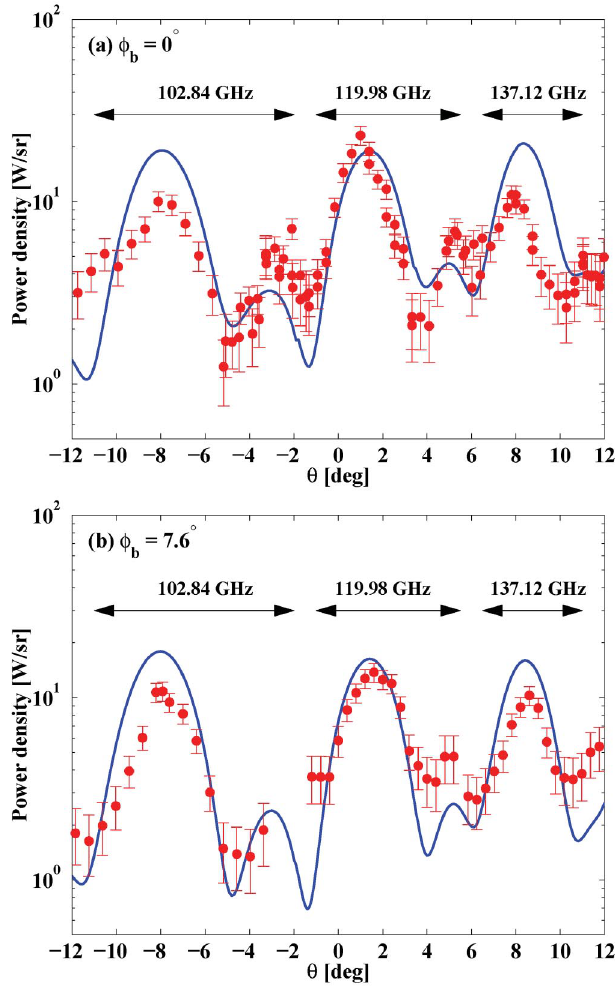
FIG. 3. (Color) Measured power density in W = sr (dots with error bars). The measurement is compared to the first-order radiated power density by the EFIE model (solid line). The power is (cid:2) 0 (cid:7) (a) and (cid:6) (cid:2) 7 : 6 (cid:7) (b). In these plotted versus (cid:5) when (cid:6) b b figures, each arrow spans over a range of angles in which the power is dominated by one discrete frequency (see Fig. 4).